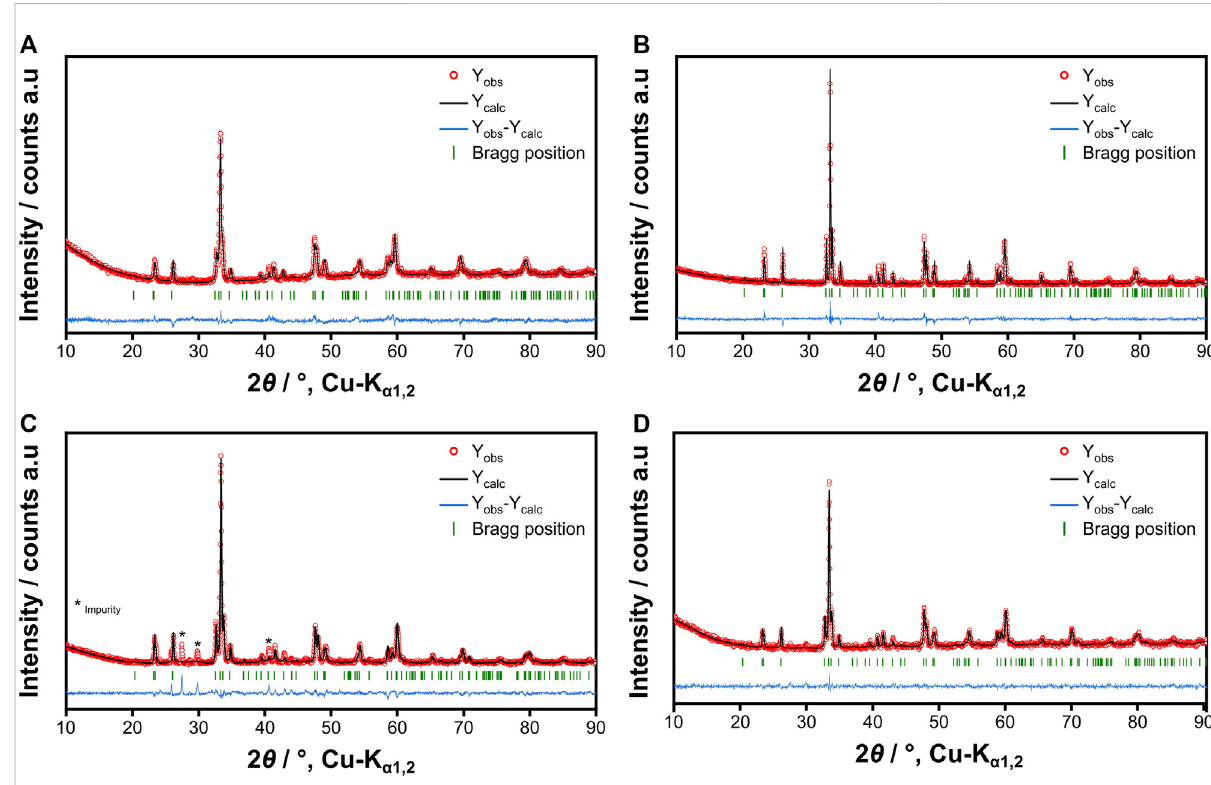
FIGURE 3 XRD patterns and Rietveld re fi nement of HEO-La_PM calcined at (A) 900 ° C and (B) 1,200 ° C, and of HEO-Sr_PM calcined at (C) 900 ° C and (D) 1,200 °